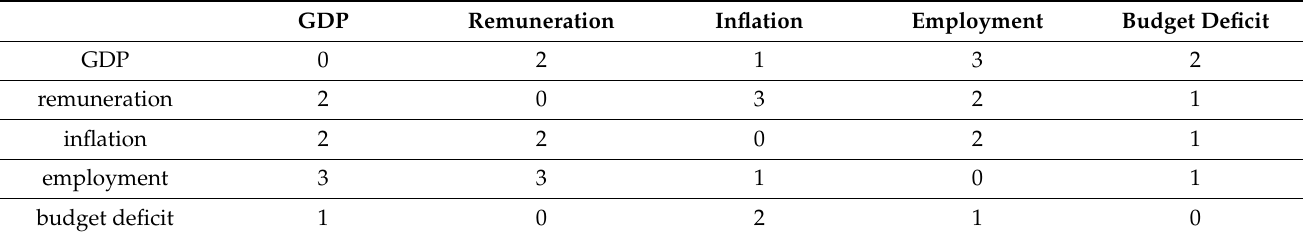
Table 2. Relationships among the economic KPI